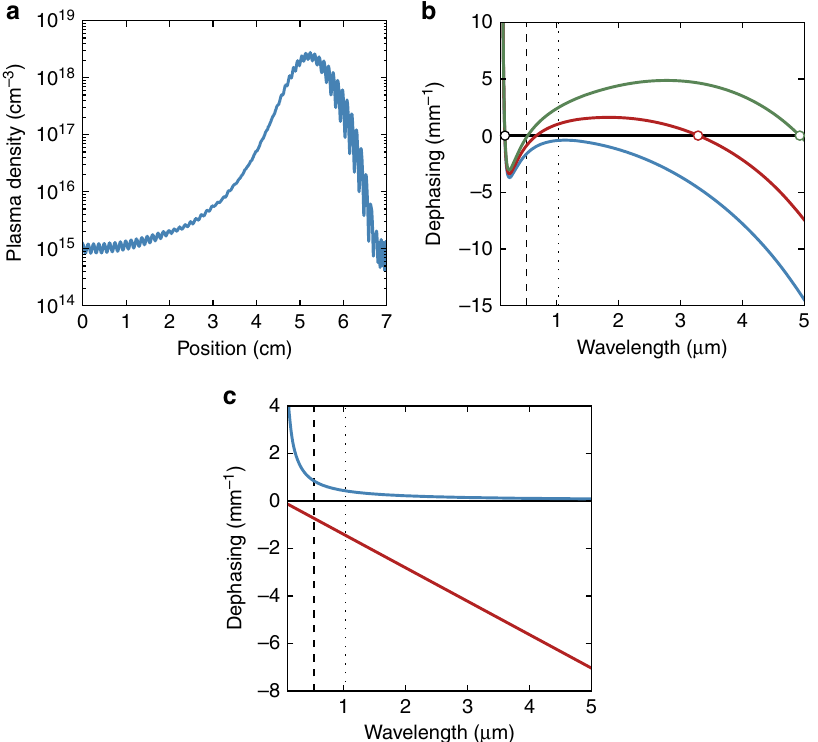
Fig. 4 Plasma density evolution and dispersive wave phase-matching. a Evolution of the plasma density with propagation distance for the simulation in Fig. 3. As the pulse propagates along the fi bre, the carrier-envelope phase (global phase 47 ) drifts and the fi eld-dependent ionization rate dithers accordingly, creating ripples in the evolution of the plasma density. b Dephasing Δ β according to Eq. (1) between a soliton with 1030 nm central wavelength (dotted line) and 1 GW peak power and dispersive waves for the case when the fi bre is fi lled with 4 bar of argon, without plasma (blue) and with plasma densities of 5 × 10 17 cm − 3 (red) and 10 18 cm − 3 (green). Phase-matching to dispersive waves is satis fi ed at zero dephasing (circles). The dashed line denotes the zero dispersion point. c Contributions of the optical Kerr effect (blue) and plasma polarization (red, plasma density 5 × 10 17 cm − 3 ) to the nonlinear soliton propagation constant